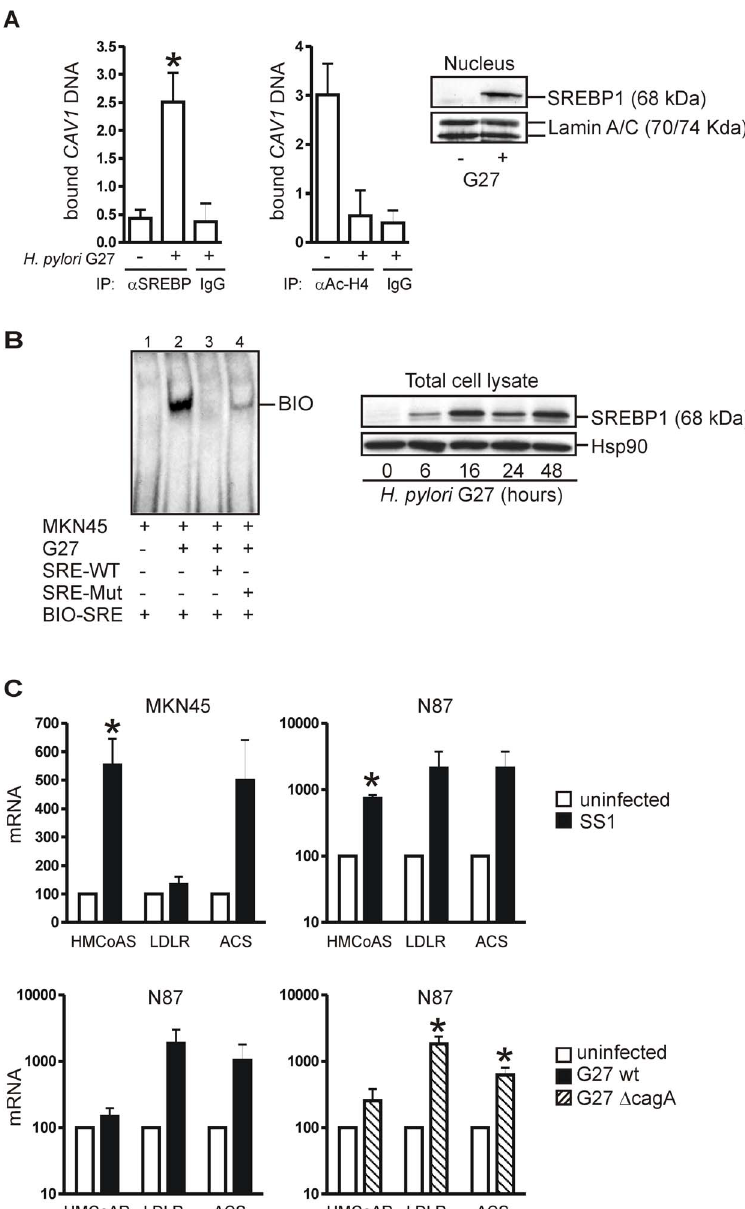
Figure 10. H.pylori strains down-regulate Cav1 promoter activity via activation of SREPB1. (A) H. pylori enhances binding of SREBP1 to one of the three sterol-responsive elements (SRE3) [24,62] in the proximal human Cav1 promoter. ChIP: MKN45 cells were infected with H. pylori G27 (MOI=100) for 16 h, and IP was performed in total cell lysates with rabbit polyclonal acetyl-H4-histone, SREBP1 or control IgG. CT-values from qPCR of IP-ed DNA were normalized to the CT-values of input DNA and were calculated as mean 6 S.E. (n=3) of protein-DNA complex pull-down by H. pylori compared to empty bead and uninfected controls; *p=0.0093 for SREBP1 and p=0.0478 for acetyl-H4-histone, H. pylori versus mock. Insert: Representative WBs of nuclear extracts showing mature 68 kDa SREBP1 in the nucleus of H. pylori G27-infected MKN45 cells. (B) EMSA: MKN45 cells were infected with H. pylori G27 for 16 h, and nuclear extracts were incubated with biotin (BIO)-labelled oligonucleotide (SRE3) [62] from the human Cav1 promoter and an excess of unlabelled competitor oligonucleotides (SRE3-WT=wild-type; SRE3-MUT=mutant). Insert: Representative WBs of whole cell lysates showing accumulation of active 68 kDa SREBP1 in H. pylori G27-infected MKN45 cells. (C) H. pylori also regulates mRNA expression of other cognate SREBP1 target genes. CT-values from RT-qPCRs on total RNA extracted from cells infected with CagA-delivery competent G27 wt , CagA-deleted G27 Delta cagA or CagA-delivery deficient SS1 H. pylori strains were normalized to b2M and presented as % 6 S.E. (n=15 per group); *p=0.0137 to 0.0196, H. pylori versus mock. phenomenon of spike-like cell elongation (‘‘humming bird’’) is within the host organ [78]. We found that Cav1 did not directly supposed to resemble, at least in part, an in vivo event which interact with CagA. Instead, Src kinase was phosphorylated on specific tyrosine residues upon infection with H. pylori G27 facilitates access of live H. pylori into favourable niches of the gastric epithelium for successful persistence of the microorganism independently of Cav1. Cav1 altered the activation status of two